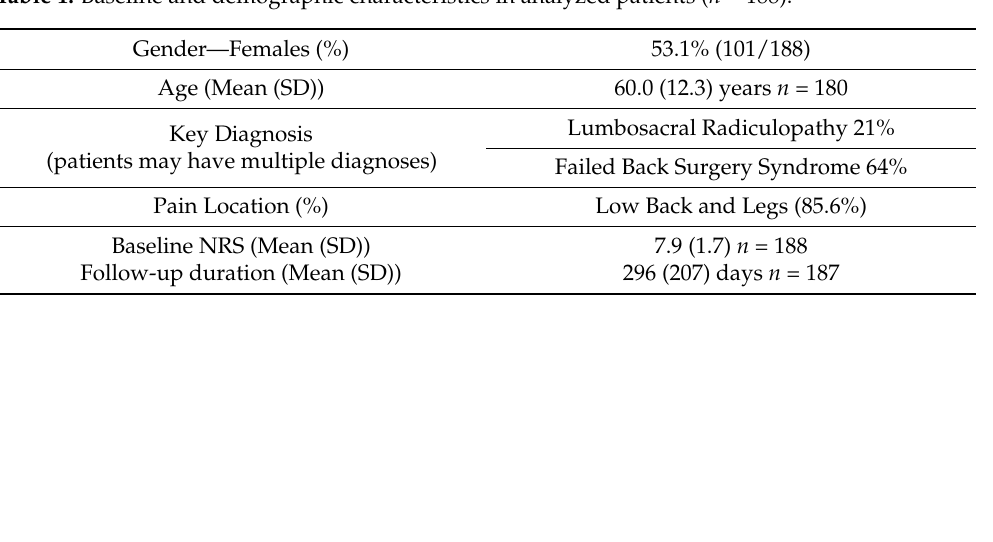
Table 1. Baseline and demographic characteristics in analyzed patients ( n =